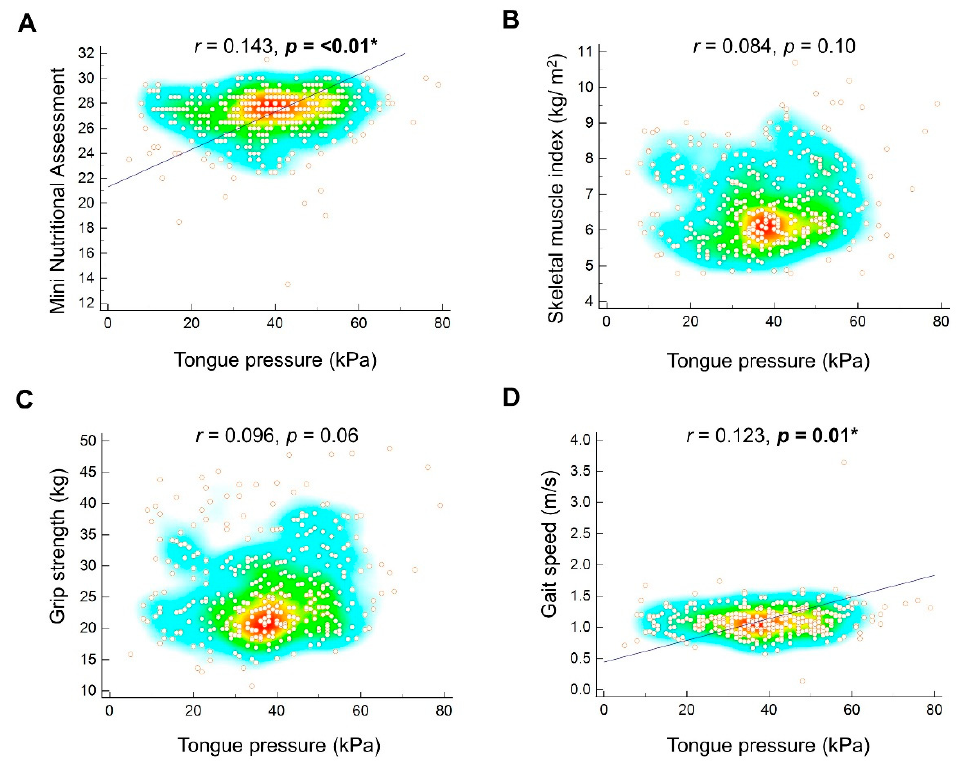
Figure 1. Correlation of tongue pressure with the mini nutritional assessment ( A ), skeletal muscle mass index ( B ), grip strength ( C ), and gait speed ( D ). The regression line is plotted and * is marked when p value is less than 0.05. The heat map with the background color coding suggests clusters of observations. Table 2. The association of risk of malnutrition with different quartiles of tongue pressure in the overall participants.